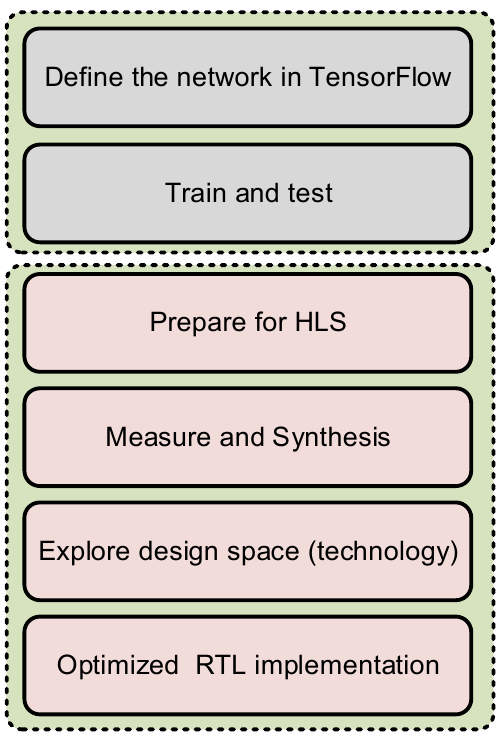
Figure 1. Top structure of CNN hardware implementation.